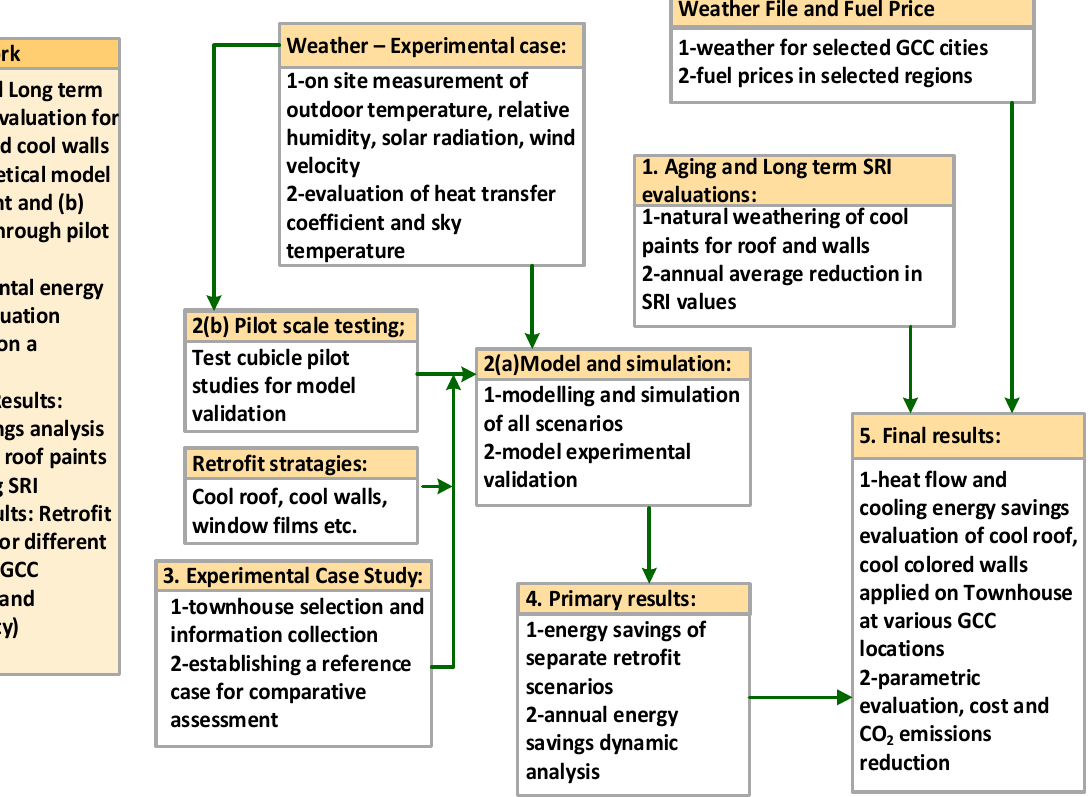
Figure 1. Methodology flow chart followed in this study.